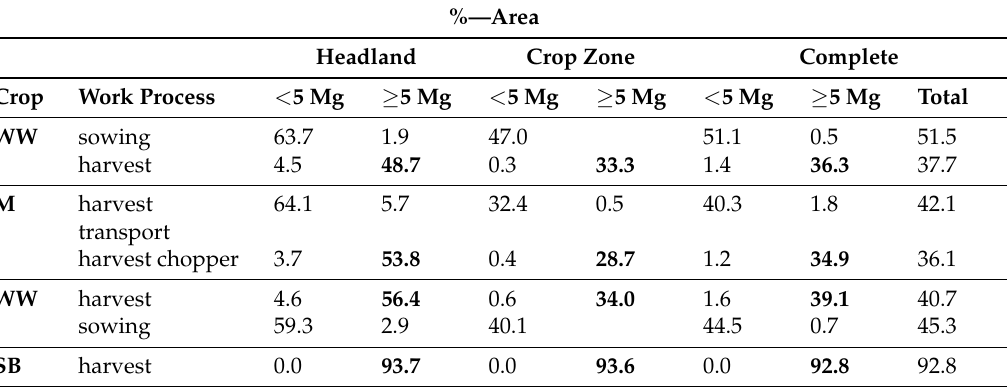
Table 3. Area percentage of the field for single work processes with under and over 5 Mg wheel load. In bold are the area shares above 10%.